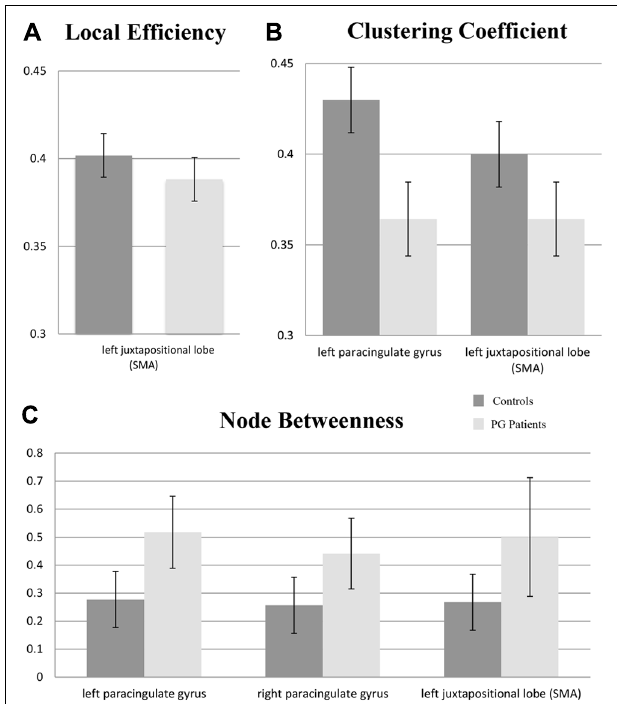
FIGURE 2 | Mean area under the curve (AUC) values for nodal metrics in regions with statistically significant group differences ( p cor < 0.05) between controls and patients with pathological gambling (PG): (A) local efficiency; (B) clustering coefficient; (C) node betweenness. Error bars reflect standard deviations; SMA: supplementary motor